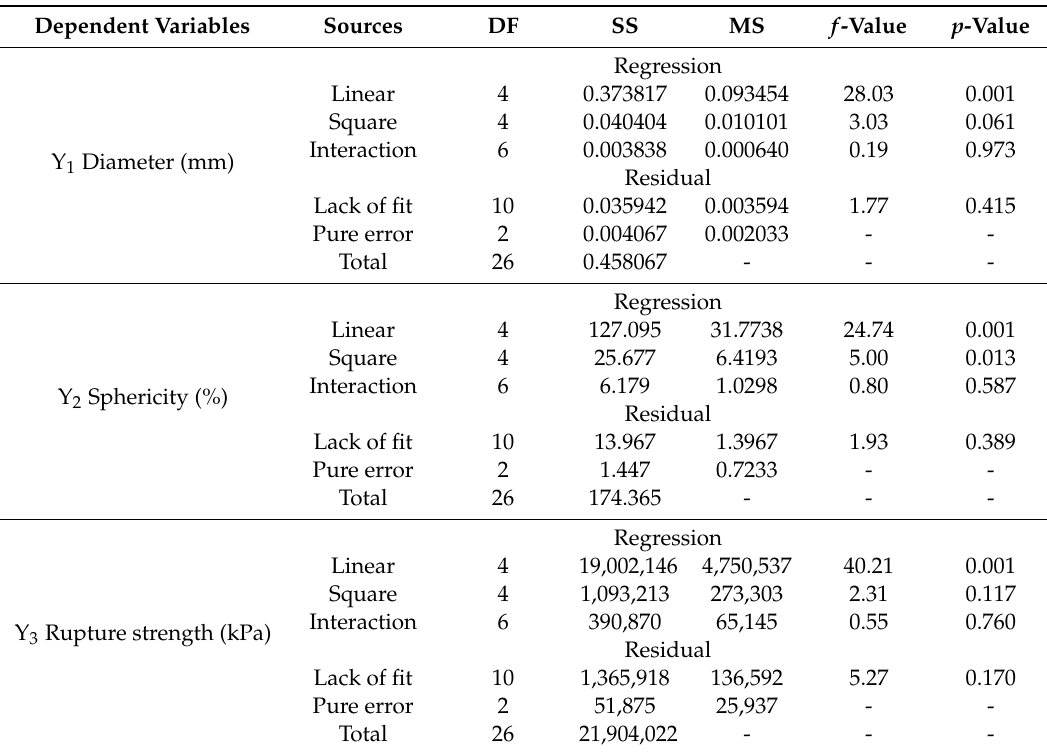
Table 5. The analysis of variance (ANOVA) of response surface model equations for monitoring the e ff ects of preparation conditions on the physical